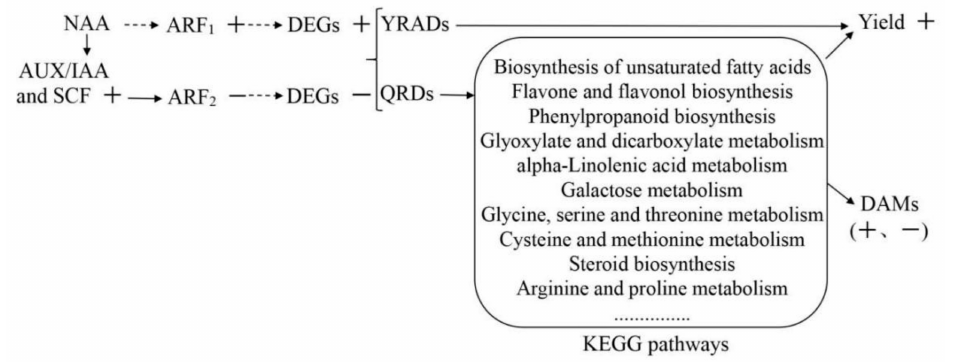
Figure 8. Regulation mechanism of NAA on the tuberous root metabolite and yield of R. glutinosa . +: up-regulated. − : down-regulated. YIRD: yield-related DEG. QRD: quality-related DEG. Virtual arrow: NAA and ARFs function via the intermediate molecule(s) unidentified by this study . . . . . . : more metabolic